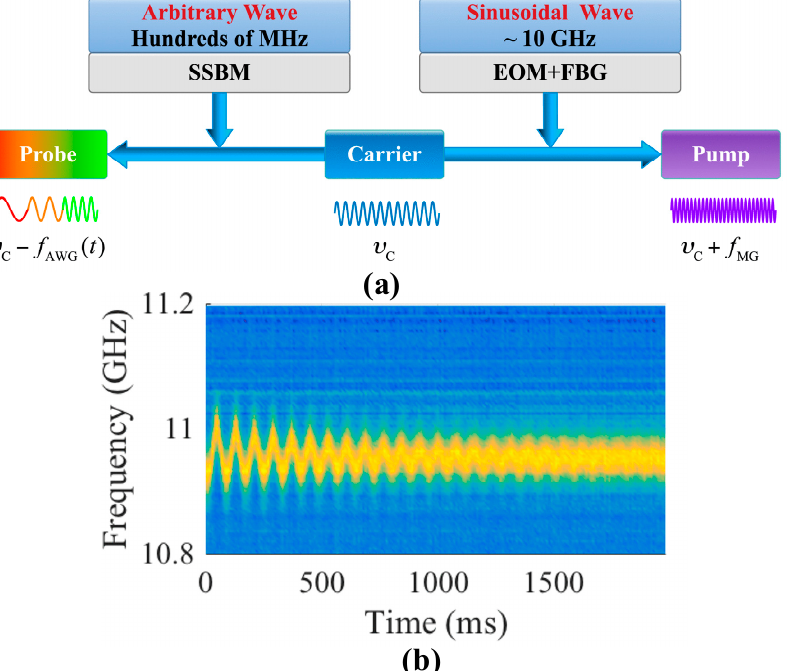
Figure 7. The fast BOTDA based on the dual modulation scheme [38]. ( a ) The dual modulation schematic diagram. The damped oscillation measurement is demonstrated as ( b ) the time-evolution of the BGS at the vibration point.